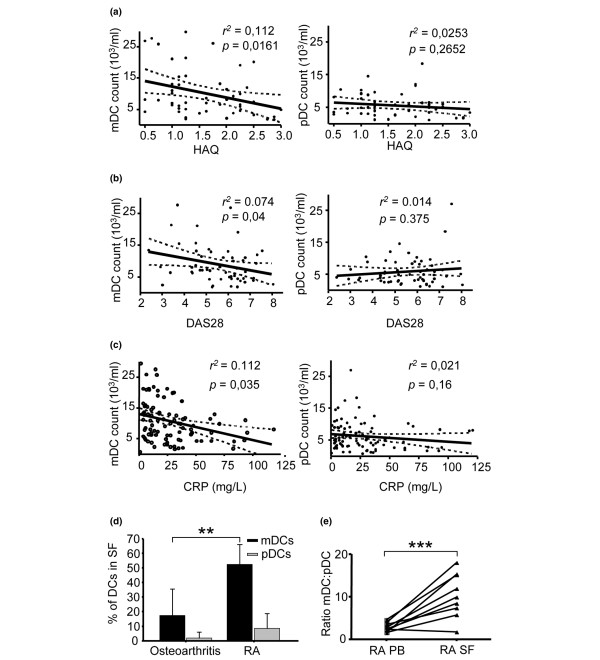
Correlation between circulating dendritic cell subsets and disease activity markers. Circulating plasmacytoid dendritic cell (pDC) and myeloid dendritic cell (mDC) counts (mean numbers/ml blood) from rheumatoid arthritis (RA) patients (n = 60) plotted against (a) Health Assessment Questionnaire (HAQ) score, (b) Disease Activity Score in 28 joints (DAS28), and (c) C-reactive protein (CRP) level. (d) The mDC level in synovial fluid (SF) of patients with active RA is significantly increased compared with that in osteoarthritis patients. Dendritic cell (DC) subsets were measured in the SF of patients with RA (n = 9) and in osteoarthritis patients (n = 11). The percentage of CD11c+CD123-HLADR+ mDCs and CD11c-CD123+HLADR+ pDCs in Lin- cells (CD3-, CD14-, CD16-, CD56-, CD8-, CD19-) are shown (mean ± standard deviation). **P < 0.001, Mann–Whitney U test. (e) The mDC:pDC ratio in SF from RA subjects is significantly increased compared with the ratio in matched peripheral blood (PB) samples. Squares and triangles indicate individual matched samples (n = 9). The ratio is calculated from the percentage of mDCs and pDCs in Lin- cells. ***P < 0.01, Mann–Whitney U test.